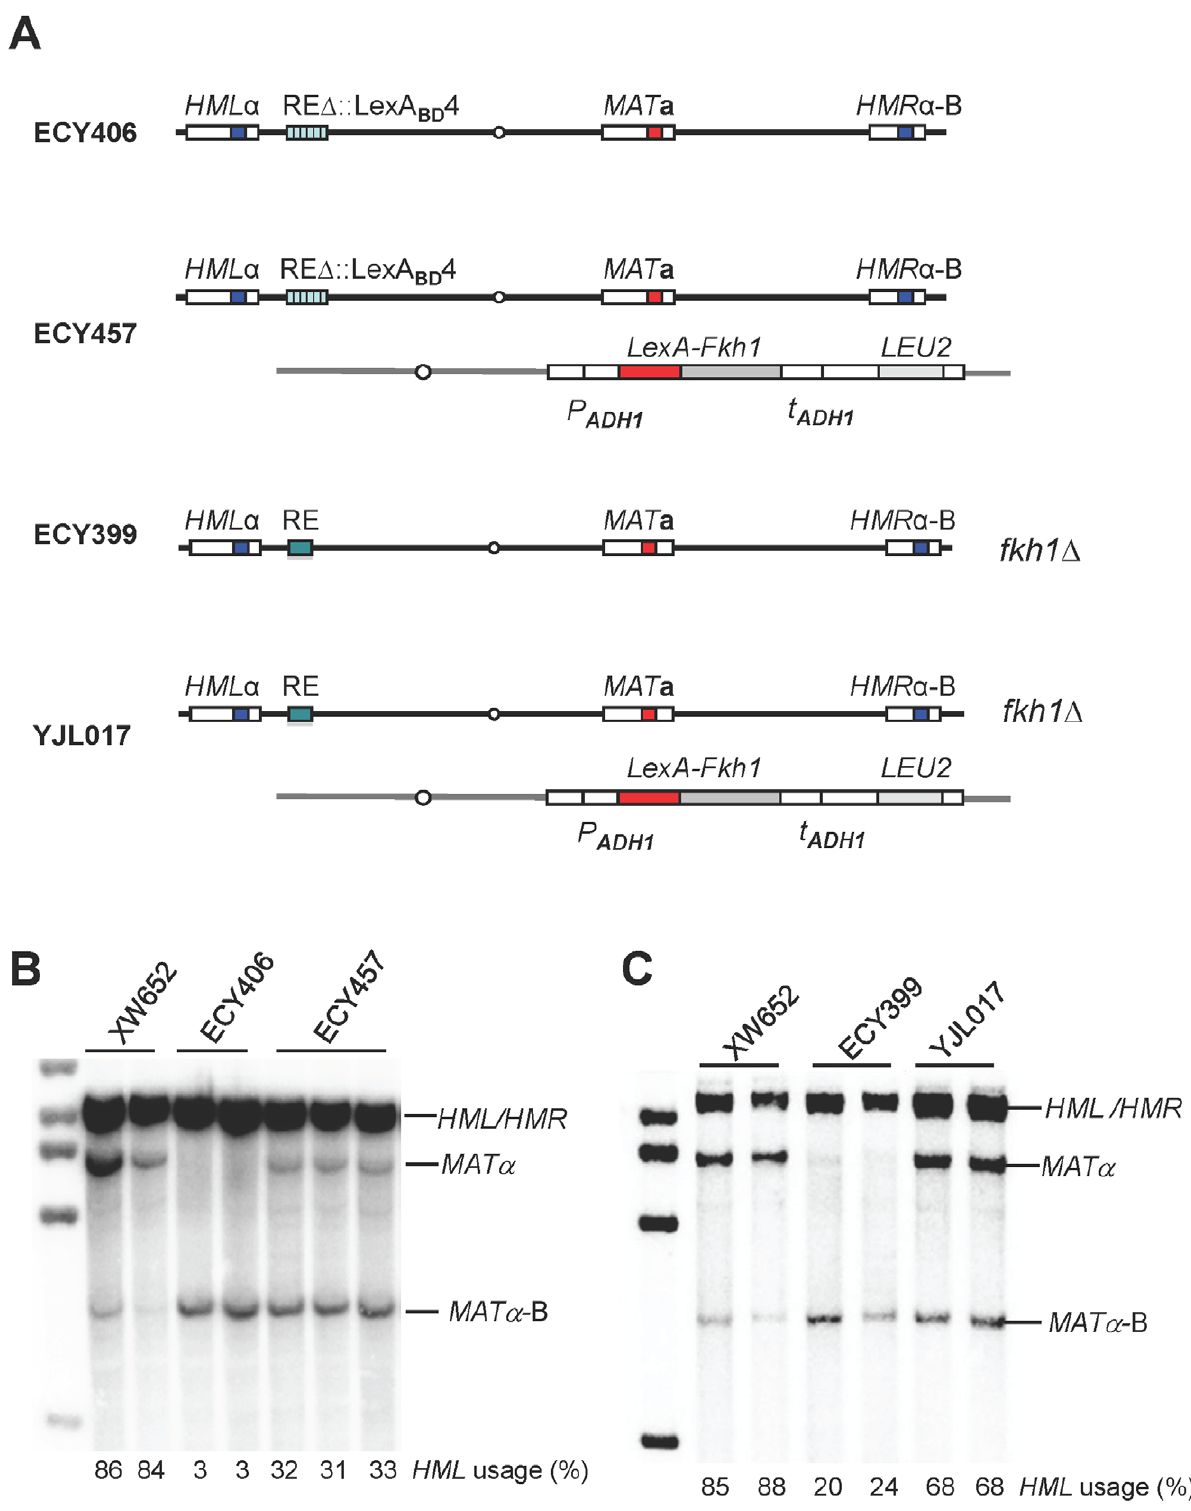
Figure 2. A LexA System to Study Donor Preference. (A) Illustration of strain genotypes for ECY406, ECY457, ECY399 and YJL017. (B) LexA-Fkh1 regulates donor preference by binding to RE D ::LexA BD 4. ECY457 was constructed by integrating LexA-Fkh1 (from pEC16) to arg5,6 of ECY406. Donor preference was measured by Southern blot using a Y a specific probe in panels B and C. XW652 serves as a wild-type control. (C) LexA-Fkh1 complements a fkh1 D mutant (ECY399) to regulate donor preference presumably by binding to RE. The arg5,6::LexA-Fkh1 was crossed into ECY399 to generate a strain YJL017.